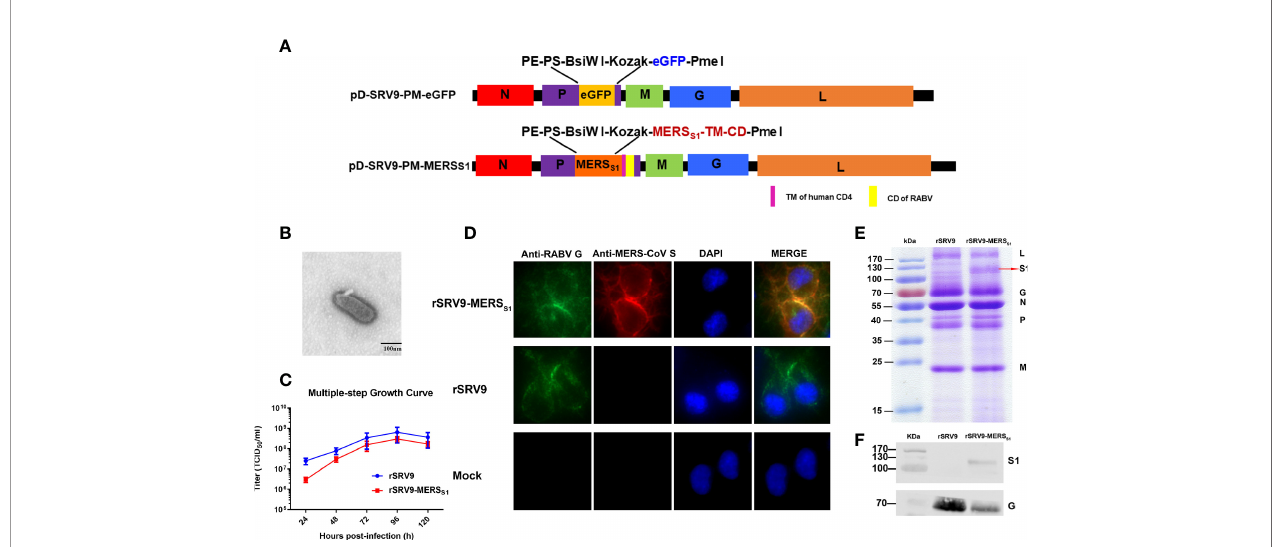
FIGURE 1 | Characterization and validation of rSRV9-MERS S1 . (A) Schematic of the candidate vaccine rSRV9-MERS S1 . The MERS S1 membrane-anchoring chimera protein gene, which contains MERS-CoV S1 gene fused to the gene of human CD4 transmembrane domain (TM) and RABV G protein cytoplasmic domain (CD), was ampli fi ed and subcloned into the enzyme cutting sites Bsi WI/ Pme I of the recombinant plasmid containing full-length RABV cDNA (pD-SRV9-PM-eGFP), generating the recombinant cDNA clone pD-SRV9-PM-MERS S1 . (B) TEM detection of rSRV9-MERS S1 . The samples of inactivated rRABV-MERS S1 viral culture supernatants were stained with 1% sodium phosphotungstate. Bar = 100 nm. (C) Multiple-step growth curves of rSRV9-MERS S1 and rSRV9 on BSR cells (multiplicity of infection (MOI) = 0.1). Cell culture supernatants were then harvested at 24, 48, 72, 96, and 120 h post-infection. Data were obtained using GraphPad Prism version 9.0 (GraphPad software). Data are shown as mean ± SD. (D) Validation of the expression of MERS-CoV S1 protein and RABV G protein in rSRV9-MERS S1 -infected NA cells by indirect immuno fl uorescence staining. NA cells infected with rSRV9 or mock-infected NA cells were used as controls. (E) Sodium dodecyl sulfate – polyacrylamide gel electrophoresis (SDS-PAGE) analysis of viral protein expression in puri fi ed rSRV9-MERS S1 virions and